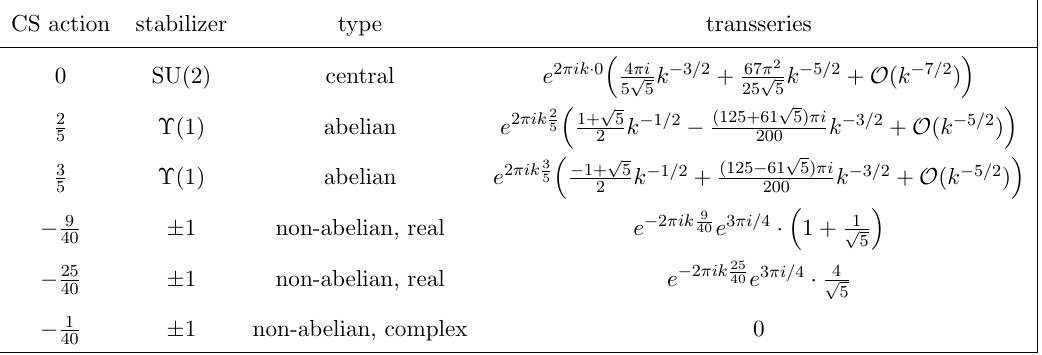
Table 19 . Transseries and classi(cid:12)cation of (cid:13)at connections on M ( factor of iq (cid:0) 19 = 40 = 2 p 2. The corresponding Weil representation is m + K = 10 + 5. (cid:0)